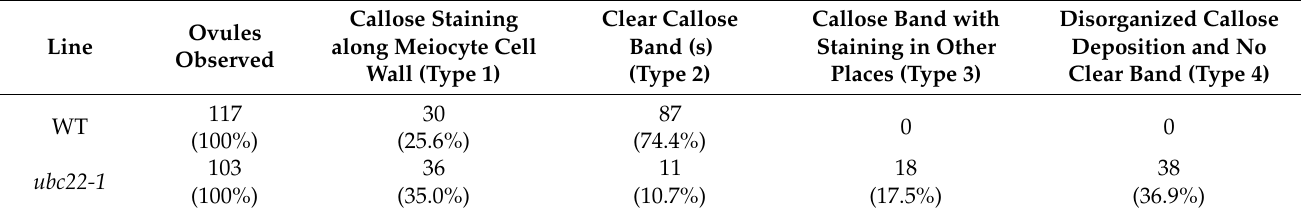
Table 1. Callose formation in the early stages of megasporogenesis in WT and ubc22-1 mutant ovules.